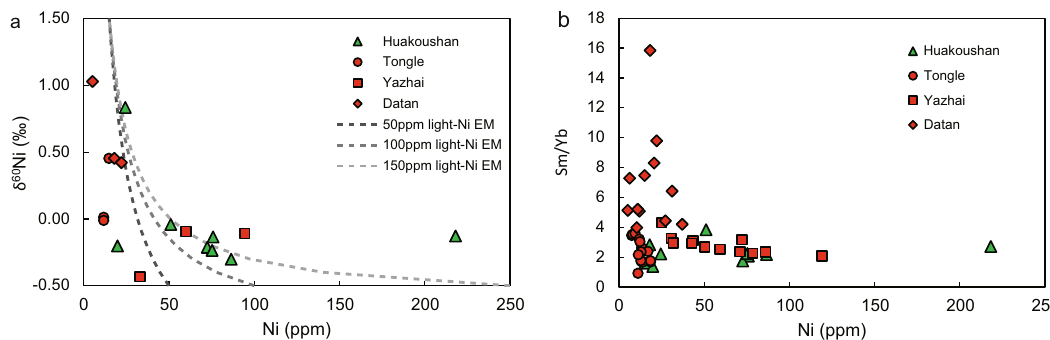
Fig. 3 The relationships between Ni concentration, Ni isotopes, and rare earth element pattern of the Nantuo pyrite samples. a Cross-plot of Ni concentration versus δ 60 Ni. There is an anticorrelation between Ni concentrations and δ 60 Ni values. Dash lines represent the relationship between Ni concentration and isotopes in a theoretical mixing model. Here, δ 60 Ni values of the two end-members are − 0.5 ‰ and + 1.5 ‰ , respectively. The Ni concentration of the high- δ 60 Ni end-member is fi xed to 20 p.p.m., while that of low- δ 60 Ni end-member is assigned to 50, 100, and 250 p.p.m., respectively. The anticorrelation between Ni concentration and δ 60 Ni could be explained by a binary mixing model. b Cross-plot of Ni concentration versus Sm N /Yb N . Here, Sm and Yb are used to represent middle rare earth element (MREE) and heavy REE (HREE) respectively. An anticorrelation is shown between Ni concentration and MREE/HREE. REE data are normalized to post-Archean Australian shale (PAAS). Green triangles, red circles, red squares, and red diamonds represent the Huakoushan, Tongle, Yazhai, and Datan sections, respectively.